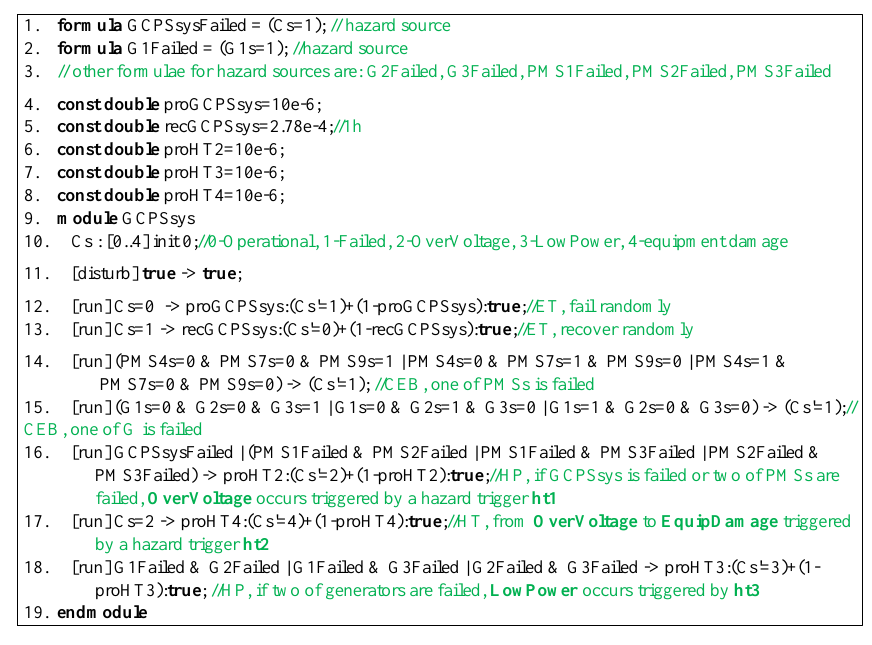
Figure 8. The PRISM-games model of GCPSsys system component.